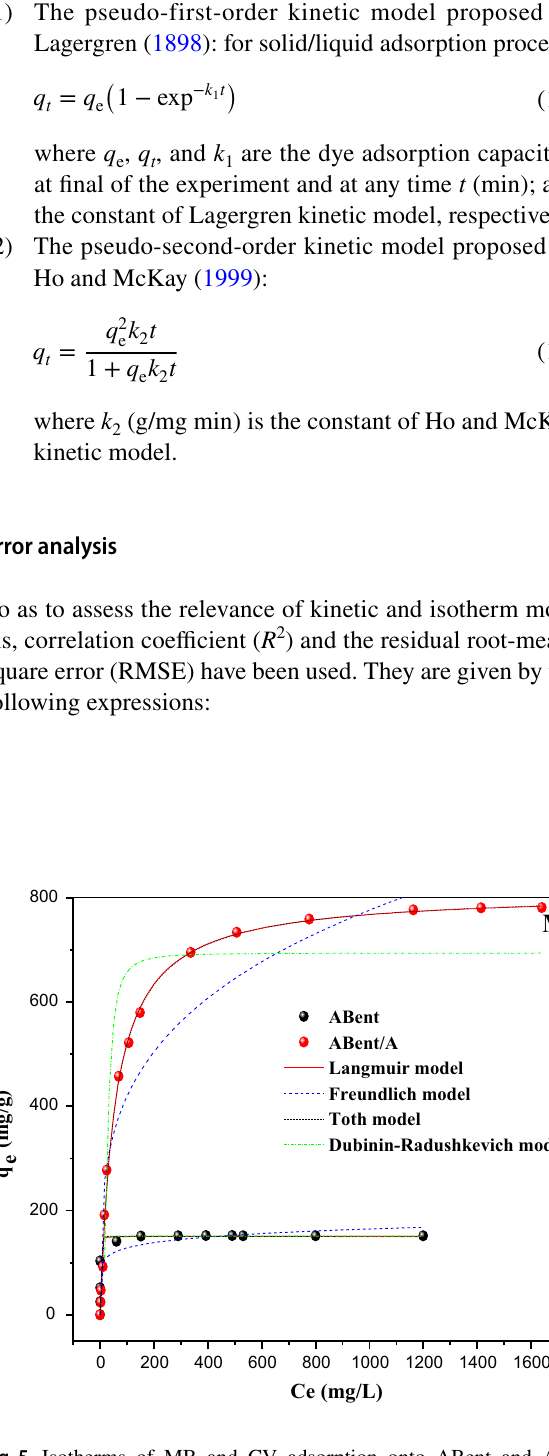
V = 10 mL, m = 10 mg, Agit = 200 rpm and 0 = 25–2500 mg/L,